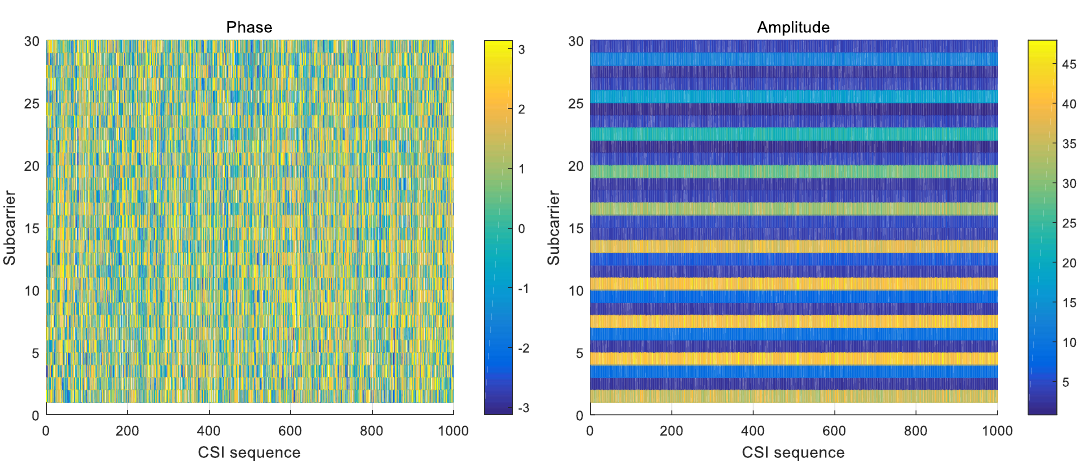
Figure 6. The phase and amplitude of 1000 packets in a static